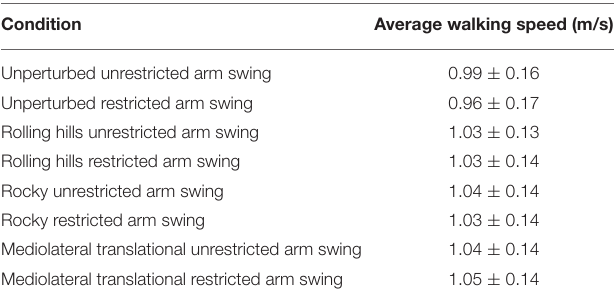
TABLE 3 | Average walking speed and standard deviation for each walking trial for arm swing conditions and destabilizing